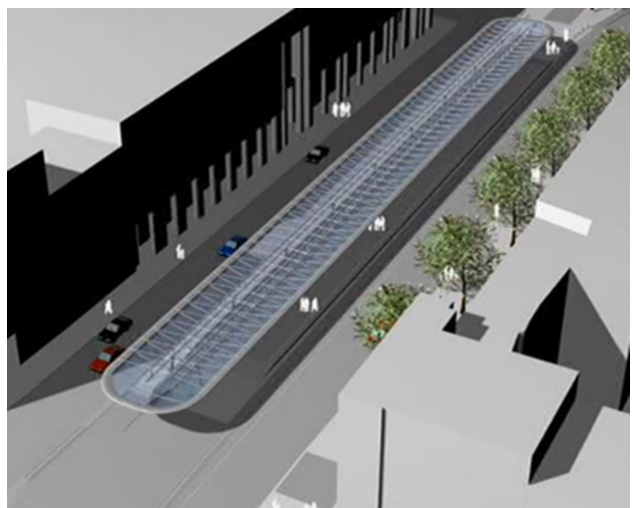
Fig. 1 Architectural design, © Stefan Schmitz